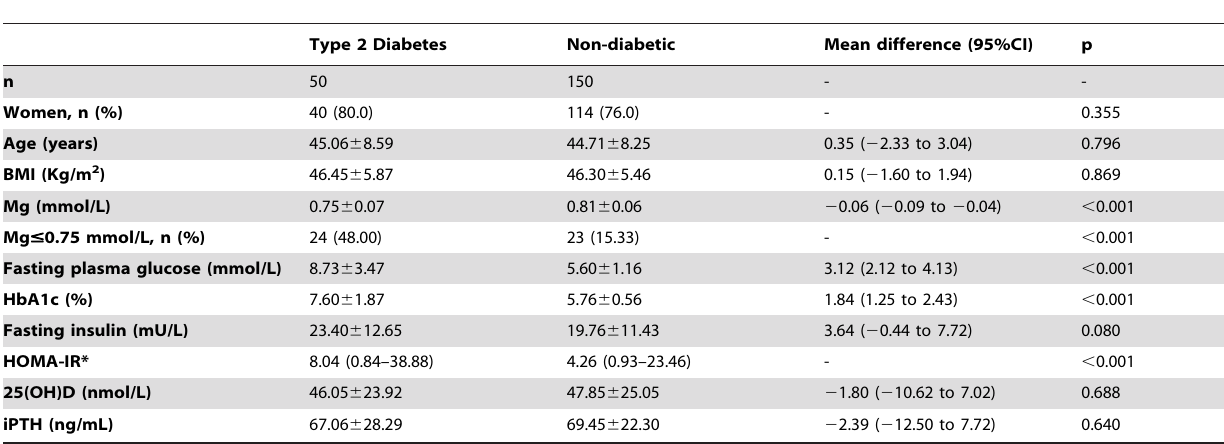
Table 1. The main clinical features and laboratory data of the study population from the cross sectional case-control study according to the presence of type 2